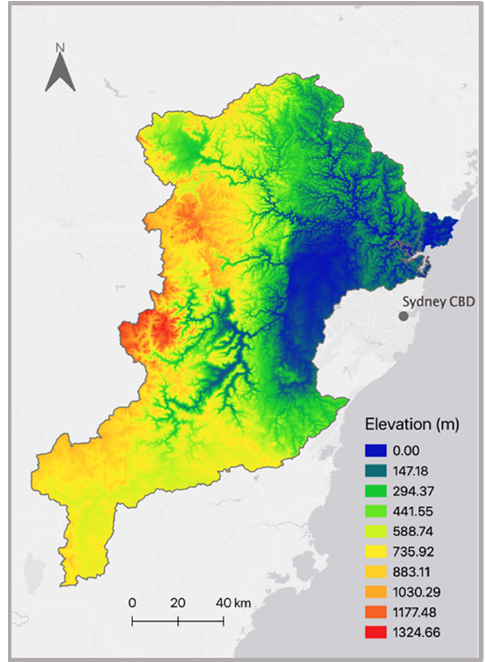
Figure 3. Map of elevation in the Hawkesbury ‐ Nepean Catchment before standardising with Fuzzy membership. Elevation is measured as metres above sea level.